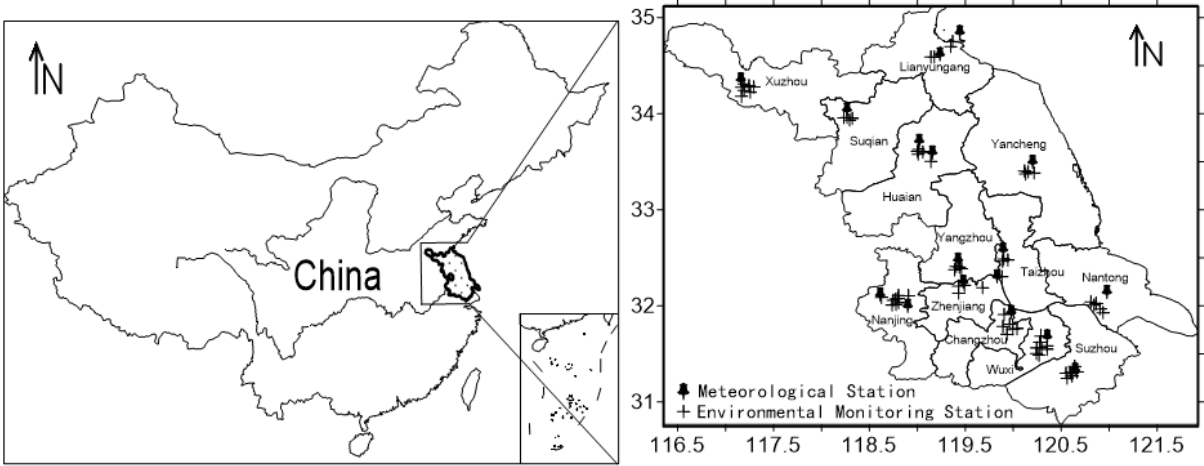
Figure 1. Geographical location of Jiangsu Province, the distribution of environmental monitoring stations, and their nearest weather stations in the study area.